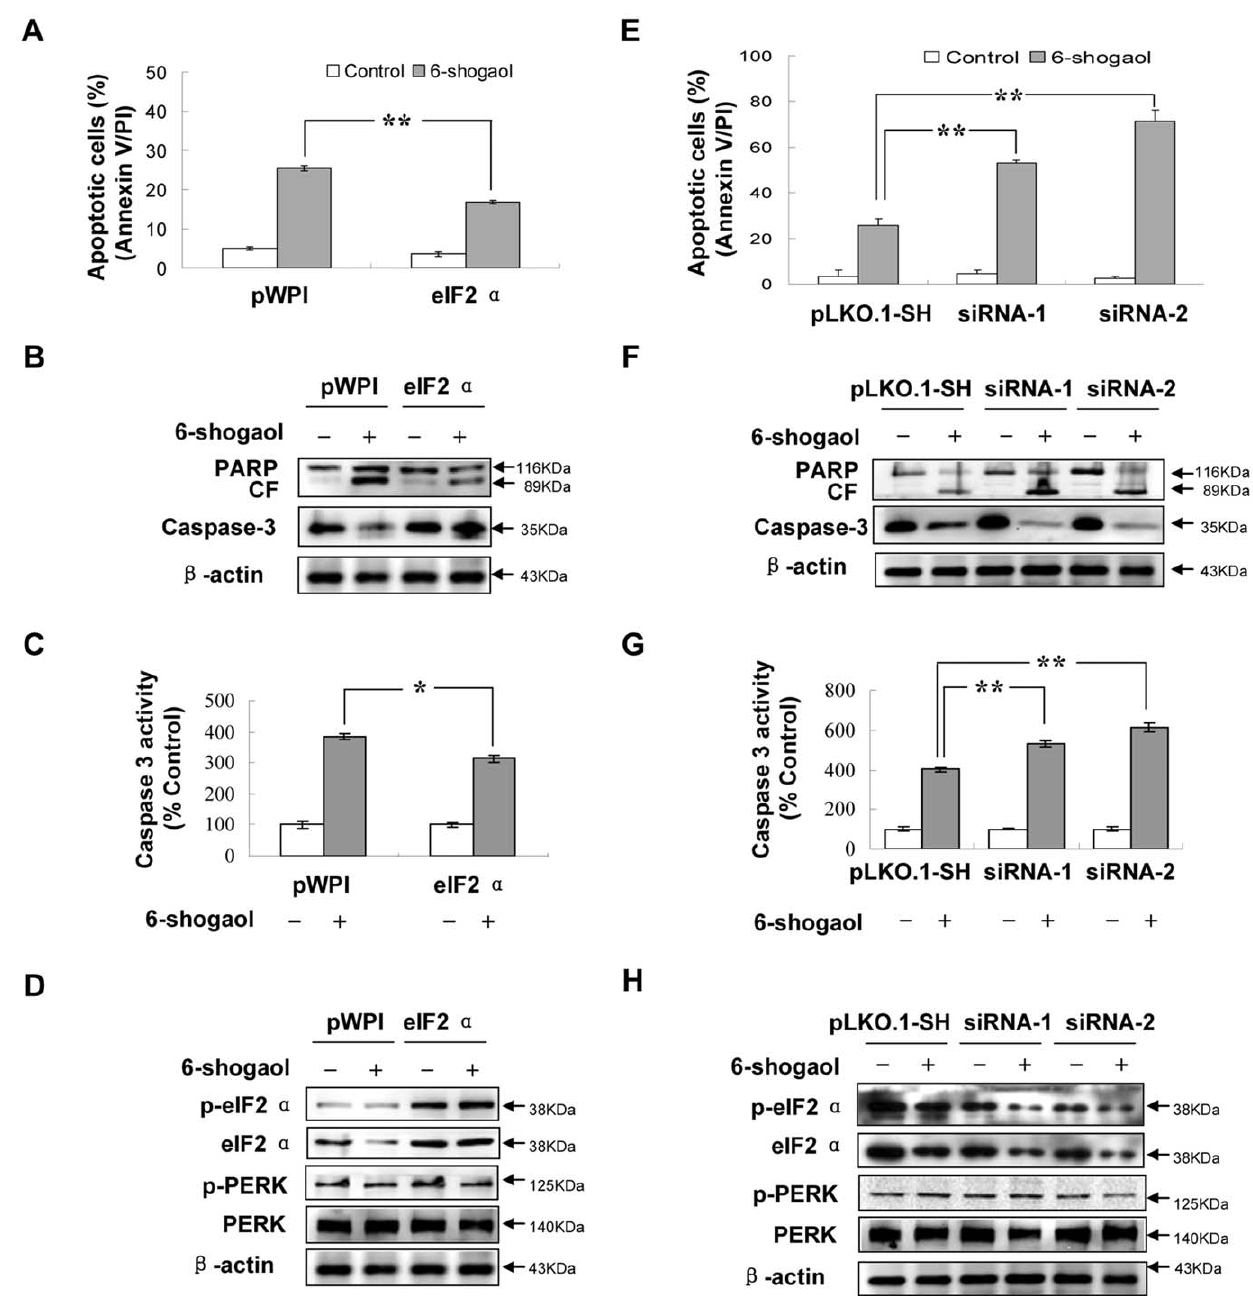
Figure 5. The role of eIF2 a in 6-shogaol-induced apoptosis. SMMC-7721 cells were stably transfected with an empty vector (pWPI) or over- expression form of eIF2 a as described in Materials and methods. All cells were then treated with 20 m M 6-shogaol for 24 h. (A) After treatment, apoptosis was determined using flow cytometry. ** P , 0.01. Total cellular extracts were prepared and subjected to (C) caspase-3 activity assay and Western blot assay using antibodies against PARP, caspase-3 (B) and PERK/eIF2 a signaling proteins (D). SMMC-7721 cells were also stably transfected with an empty vector pLKO.1-SH or eIF2 a siRNA (two clones siRNA-1 and siRNA-2). Cells were then treated with 20 m M 6-shogaol for 24 h. (E) After treatment, apoptosis was determined using flow cytometry. ** P , 0.01. Total cellular extracts were prepared and subjected to (G) caspase-3 activity assay and Western blot analysis using antibodies against PARP, caspase-3 (F) and PERK/eIF2 a signaling proteins (H). CF stands for cleavage fragments of